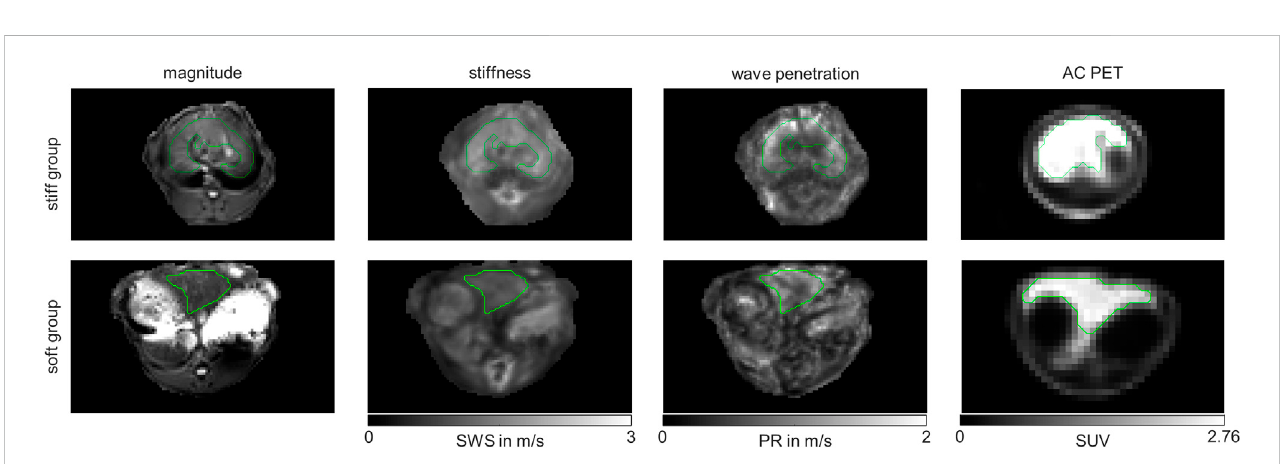
FIGURE 5 Representative MRE magnitude, stiffness indicated by shear wave speed (SWS), wave penetration indicated penetration rate (PR) and attenuation corrected (AC) positron emission tomography (PET) maps of in vivo rabbit liver. Shown are representative examples from the stiff liver (SWS > 1.6 m/s) and soft liver (SWS < 1.6 m/s) group. Maps are shown in grey-scale. Liver regions of interests (ROIs) are demarcated by green